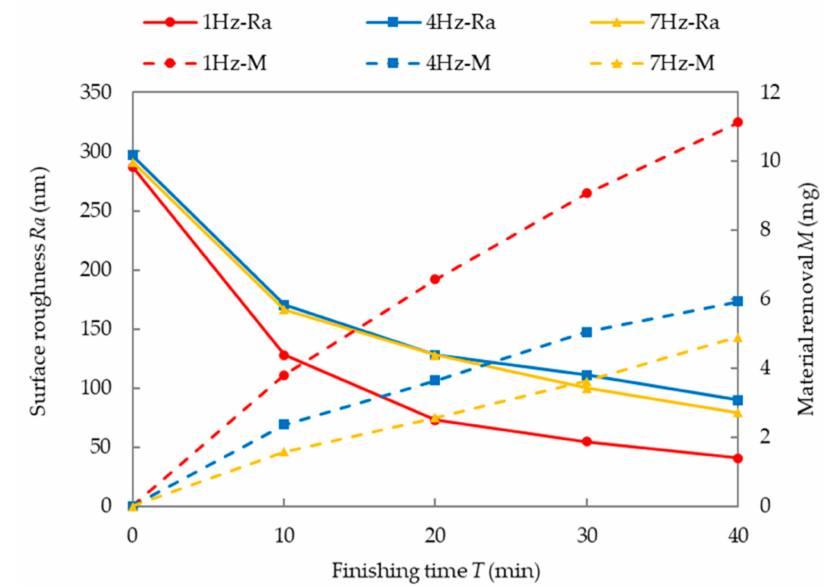
Figure 12. The e ff ect of current frequency on surface roughness and material removal. (Magnetic particles: 149 µ m, current waveform: S-AC, abrasive particles: WA#8000, rotational speed: 350